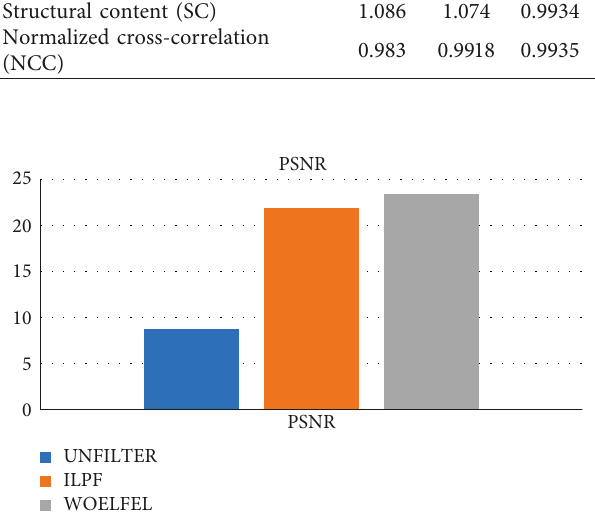
Figure 14: Comparison plot for PSNR values.